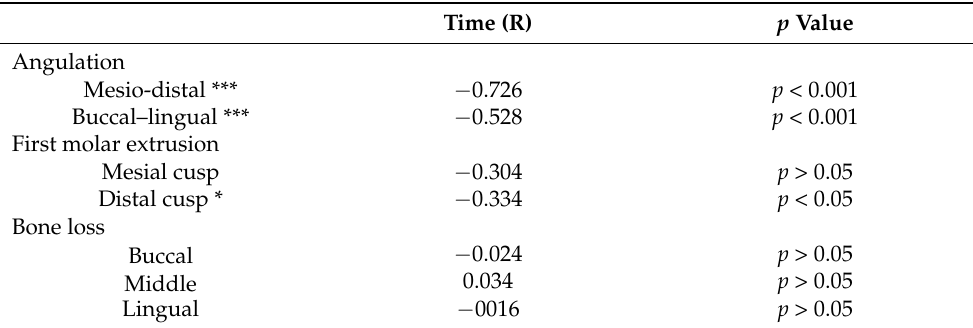
Table 4. The correlation coefficients of each parameters and duration of tooth loss.